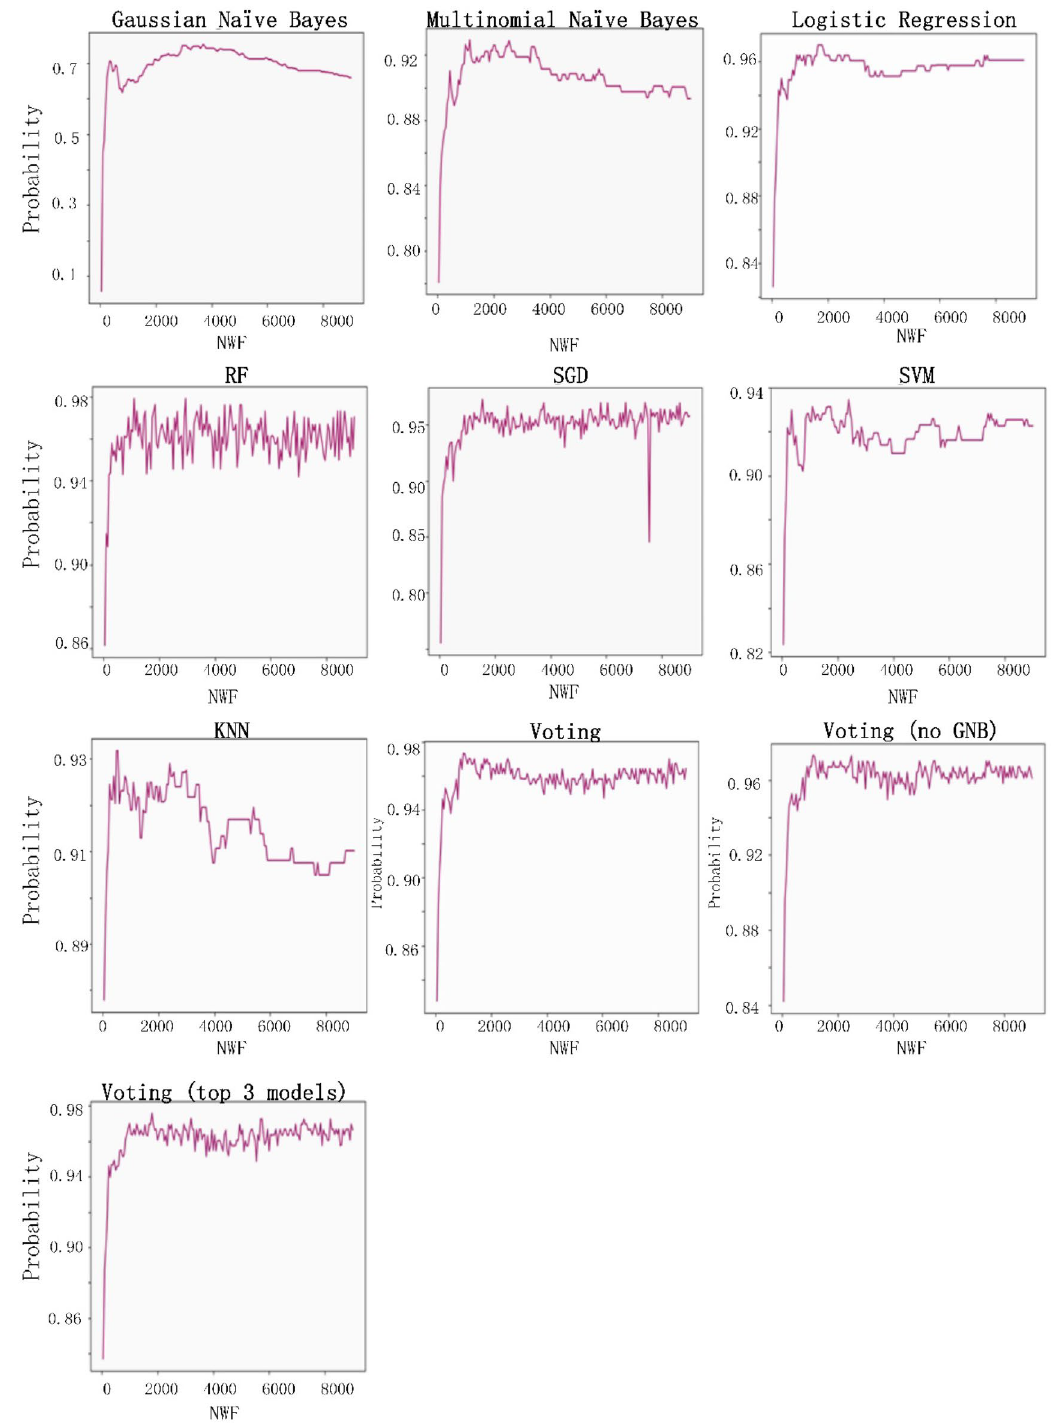
Figure 10. F1-score performance data for the eight classifiers examined in this